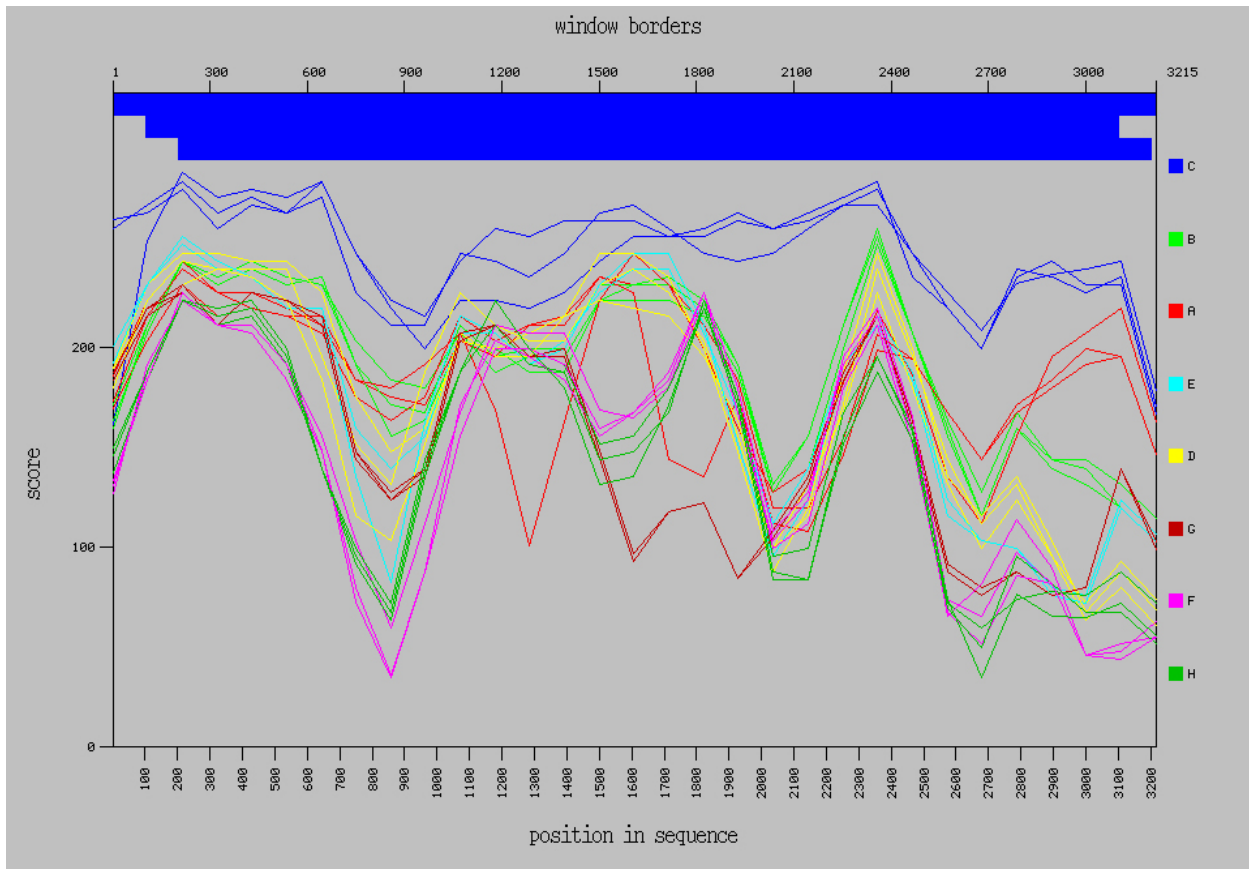
Figure 1. Recombination analysis of the isolate NHB17965. The Simplot diagram was generated using the NCBI Genotyping tool.